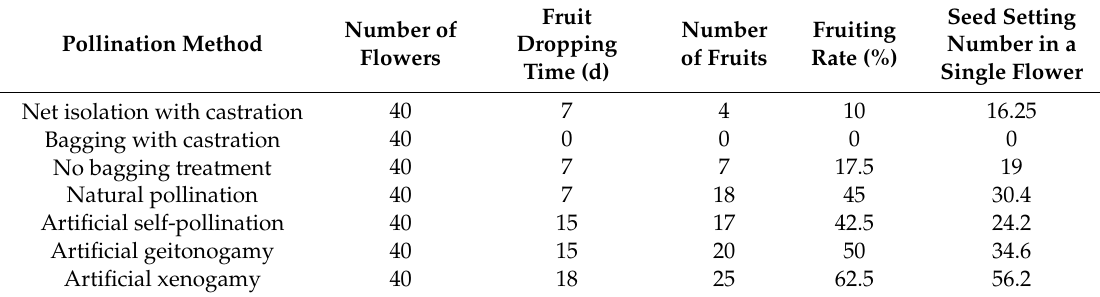
Table 2. Fruit setting rate and seed setting number under di ff erent pollination